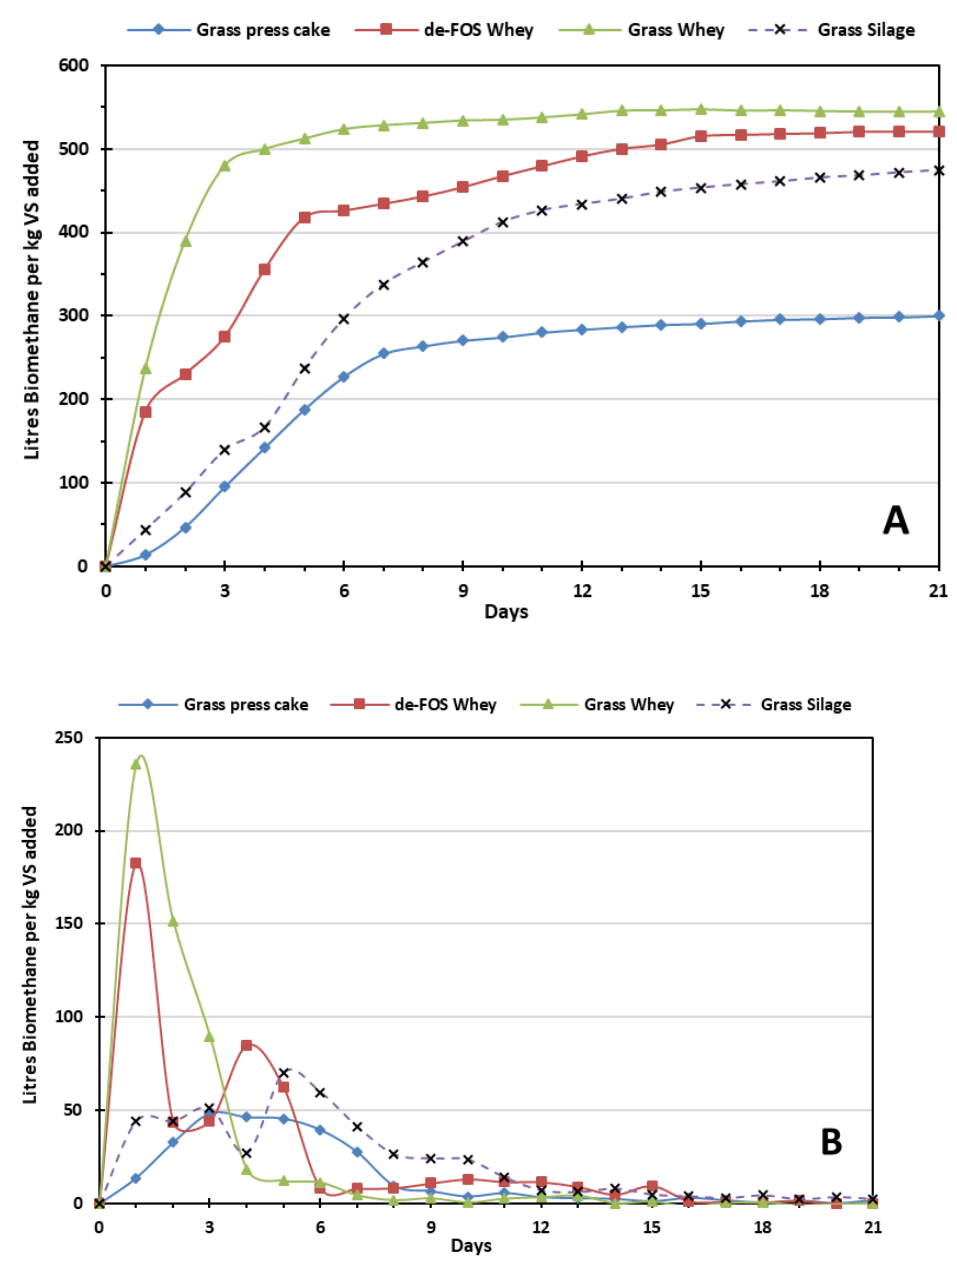
Figure 2. Cumulative ( A ) and daily ( B ) biomethane profiles for grass silage, grass press cake, whey and de-FOS whey.